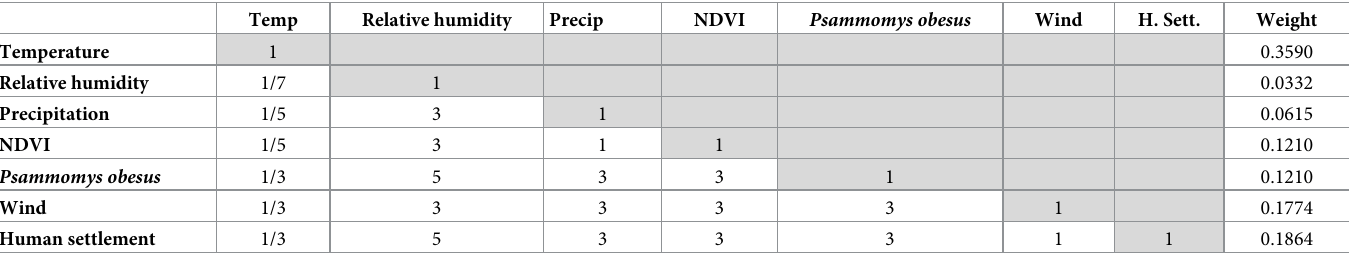
Table 6. Pairwise comparison matrix of the analytical hierarchy process (AHP) for the predictors associated with the occurrence of Phlebotomus papatasi in Jordan. Based on the first author’s subjective judgment constructed from the literature review in Section